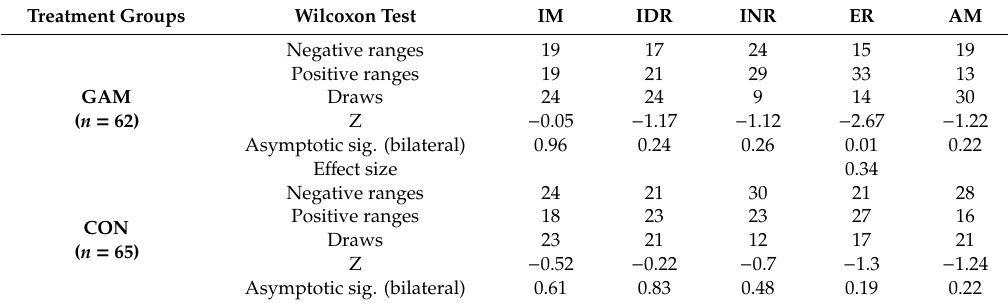
Figure 3. Box diagram of the motivational variables measured in a questionnaire CMEF (pre-test). Table 5. Results for each educational group in the Wilcoxon test (pre-test vs. post-test). Treatment